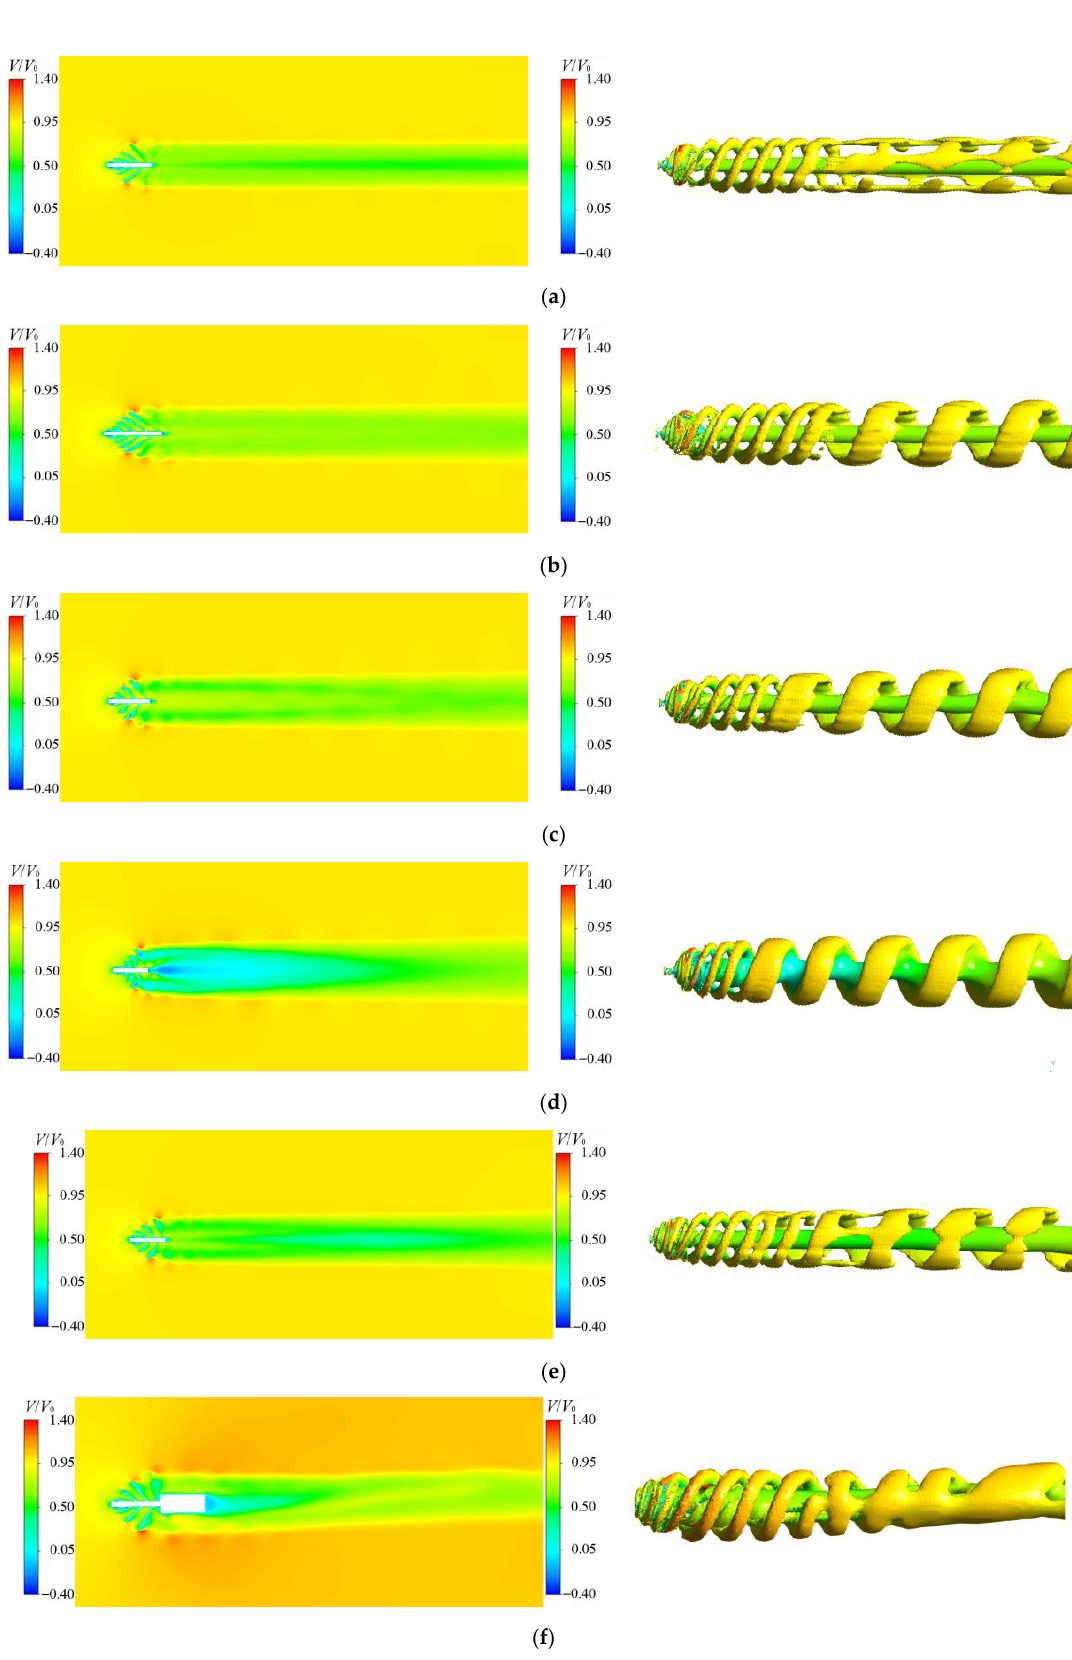
Figure 15. Velocity contours ( left ) and vortex structures colored by velocity ( right ) for the five ASWT rotors at TSR = 1.5 in the central x - z plane: ( a ) 15-30-45; ( b ) 30-30-30; ( c ) 45-45-45; ( d ) 60-60-60; ( e ) 30-45-60; ( f ) 30-45-60 with tower.